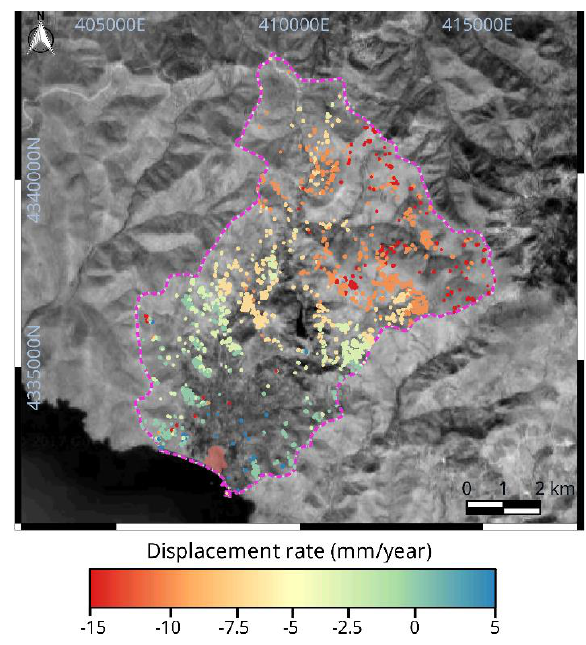
Figure 5. Deformation rate map of Eressos basin derived using the means of Sentinel-1 SBAS analysis. The colour scale represent the LOS velocity of the surface. The background image is a grayscale of high resolution